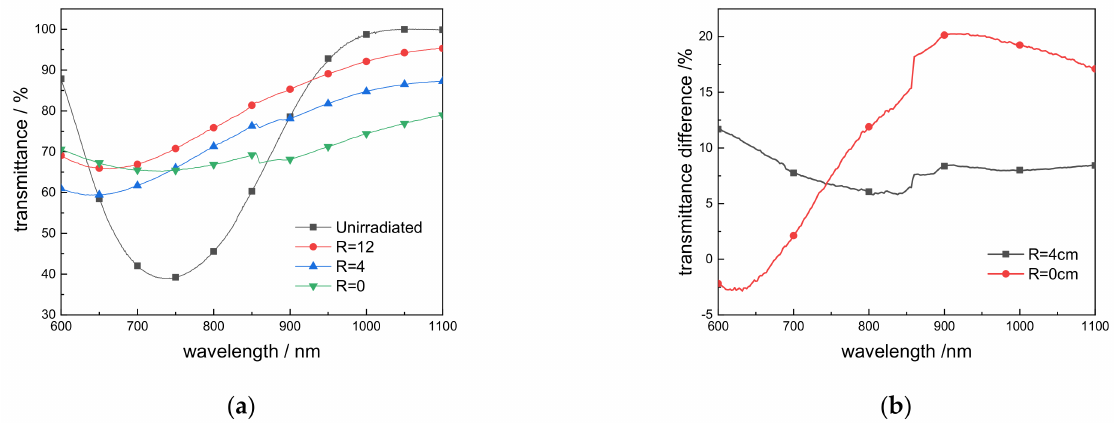
Figure 3. ( a ) Transmittance at glass R = 0 cm, R = 4 cm, R = 12 cm and unirradiated coated glass; ( b ) Transmissivity difference ∆ T = (T − Ti)/T R = 12 R = 12 . i = 0 cm, 4